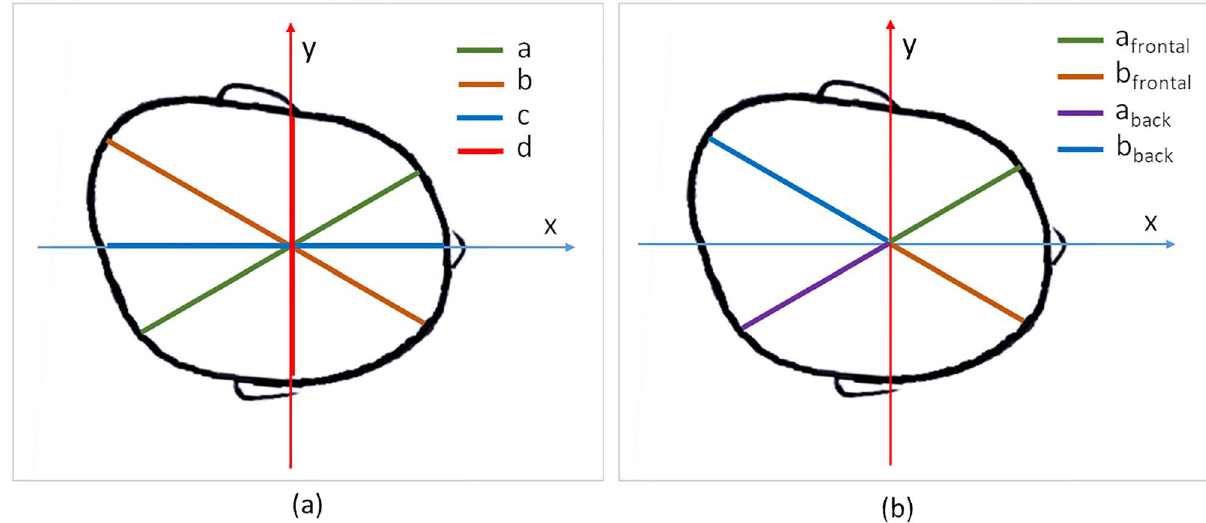
Figure 2. Visualization of measurements taken for the computation of the anthropometric deformation indexes: ( a ) traditional measurements undertaken with conventional analogue solutions; ( b ) extra measurements extracted automatically with